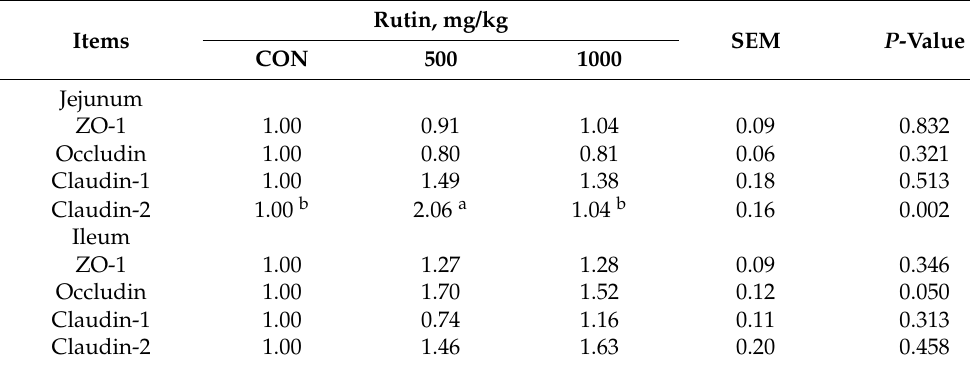
Table 4. Effects of rutin supplementation on the relative mRNA abundances of tight junction in the intestine of aged laying